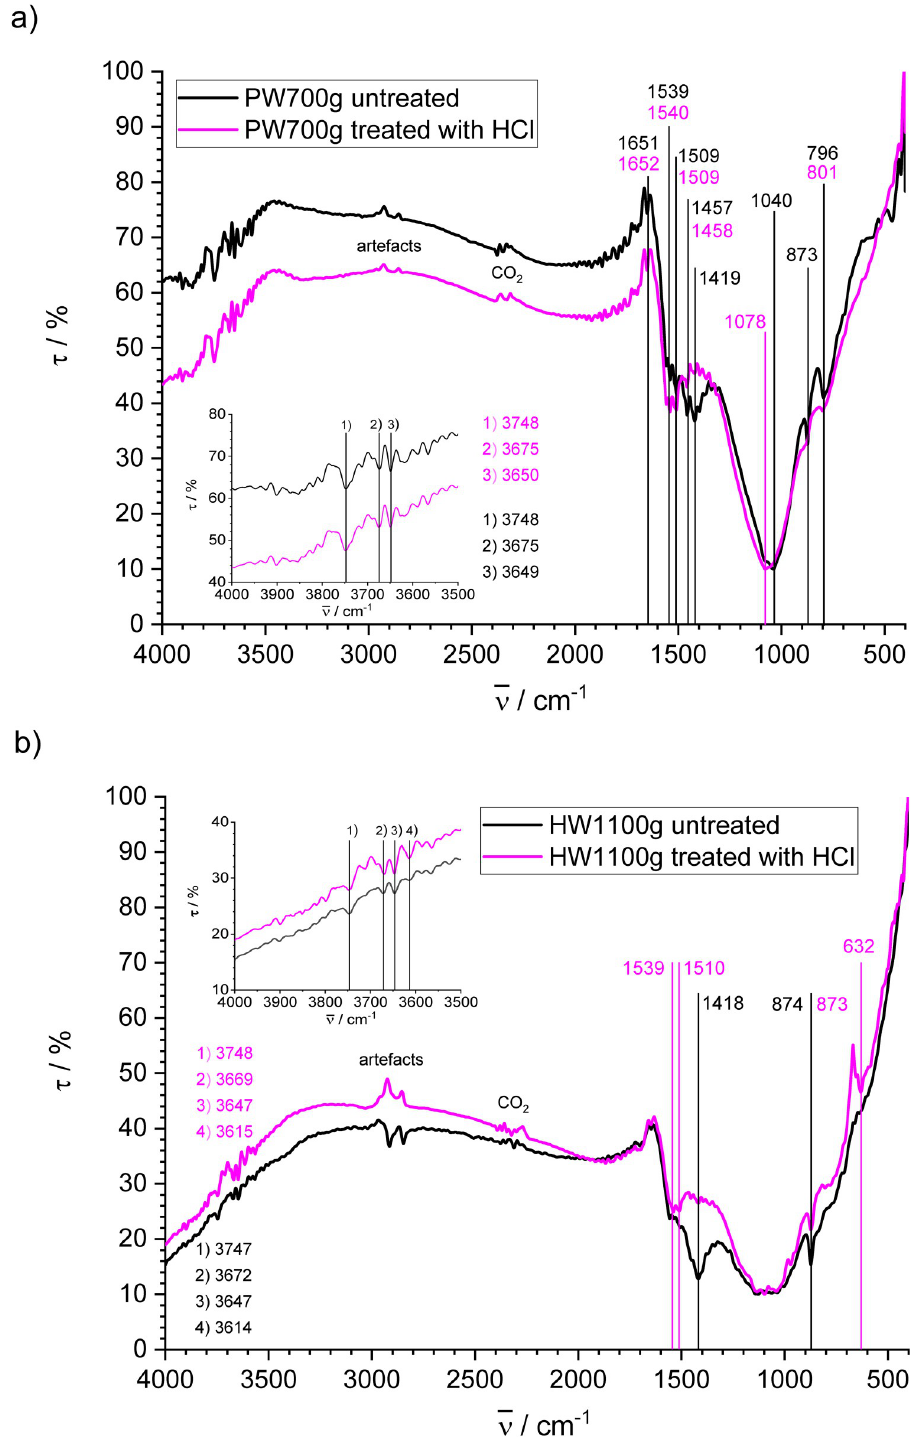
Fig 7. FT-IR spectra of biochars made by gasification and untreated or treated with HCl; a) PW700g; b) HW1100g.